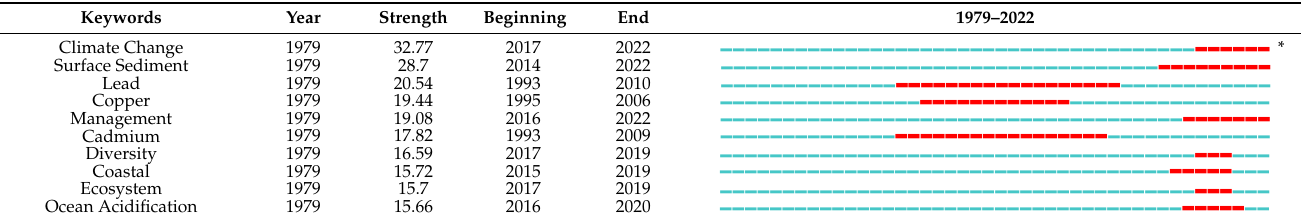
Table 1. The top citation bursts of the selected keywords in publications about the impacts of climate change on heavy metal contamination in coastal areas, based on the Web of Science Core Collection database (1979 – 2021). Keywords